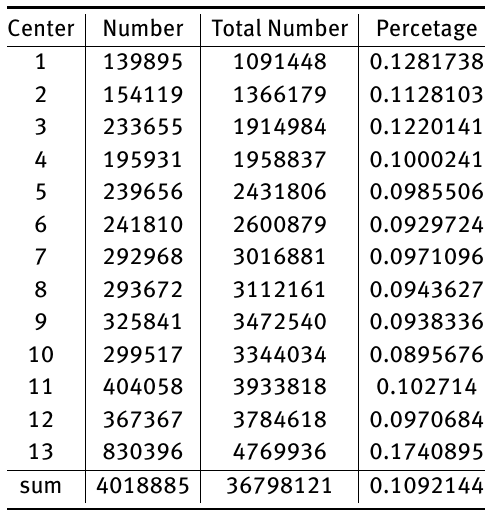
Table 4: The number and the percentage of Frénicle-Amela-Like patterns for MS-